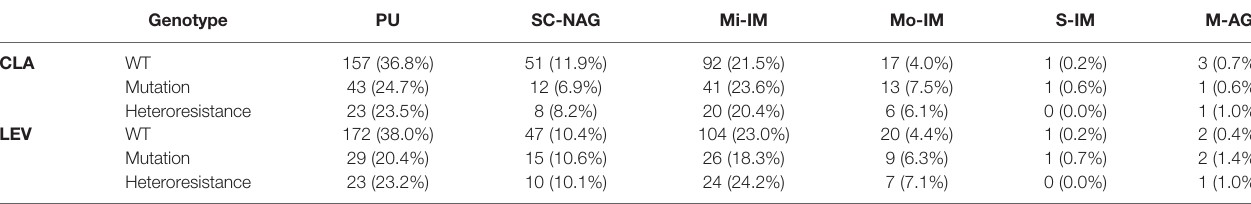
TABLE 2 | The relationship between different genotype and endoscopy/pathologic diagnoses.